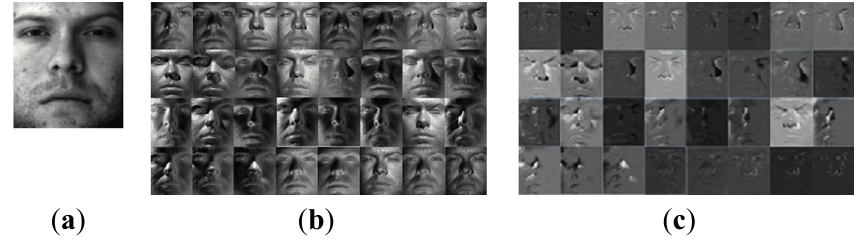
Figure 1. The illustrative examples of the facial variation model based on Yale B database. ( a ) The “prototypes” derived by averaging the images of the same subject; ( b ) The “sample-to-centroid” variation images of SSRC method; ( c ) The intra-class difference of the “sample-to-centroid” variation images of our